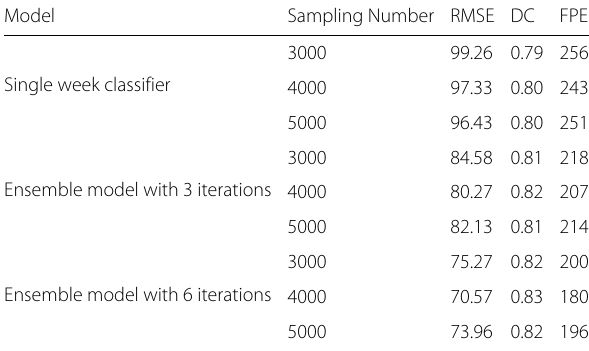
Table 2 Performance comparison with different sampling number of samples and training iterations